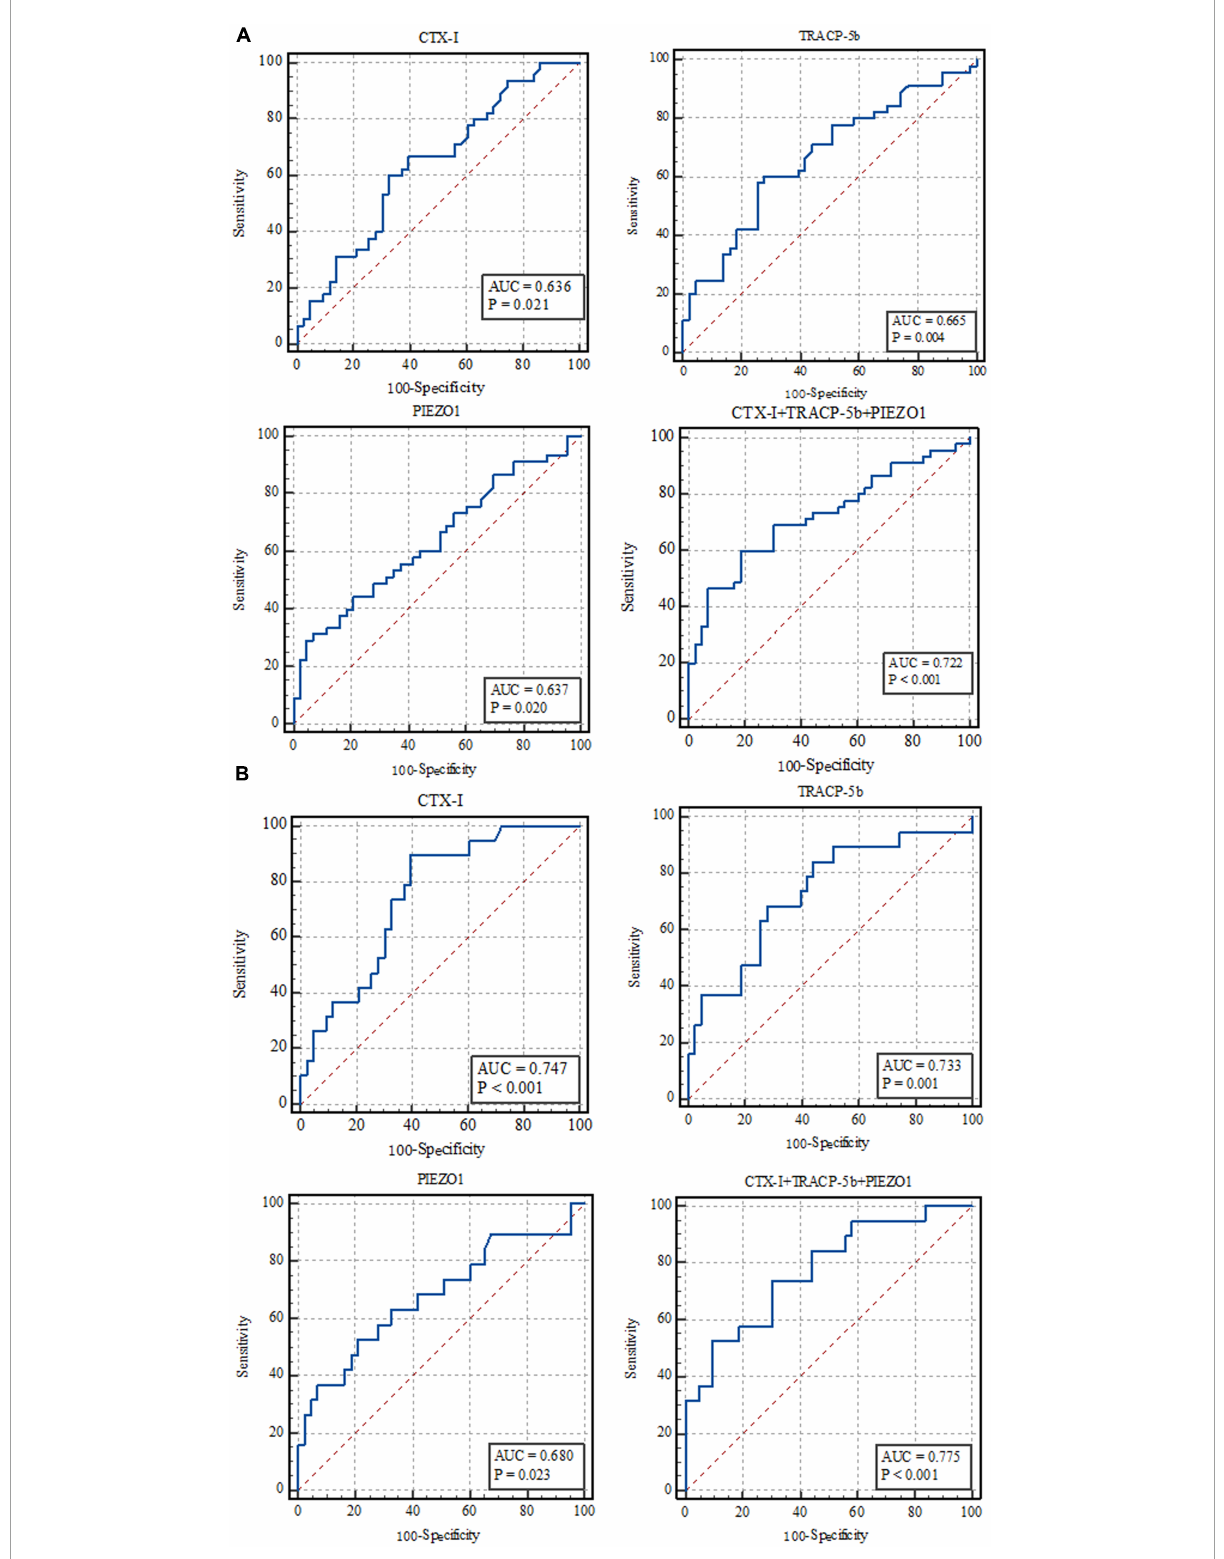
FIGURE3 ROC analysis results. (A) Sepsis vs. non-sepsis; (B) sepsis shock vs.